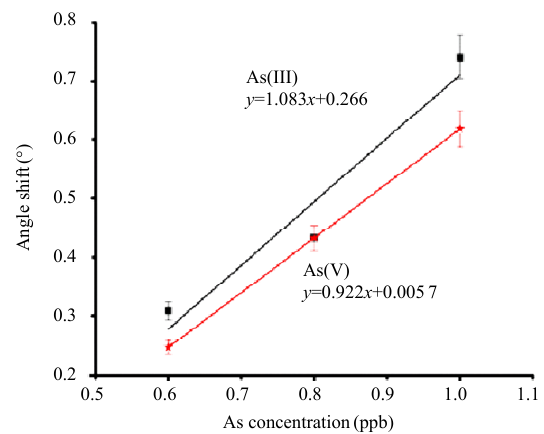
Fig. 7 Sensitivity of Fe 2 H 2 O 4 –SPR sensor towards As(III) and As(V) with a standard deviation of ±0.1°.